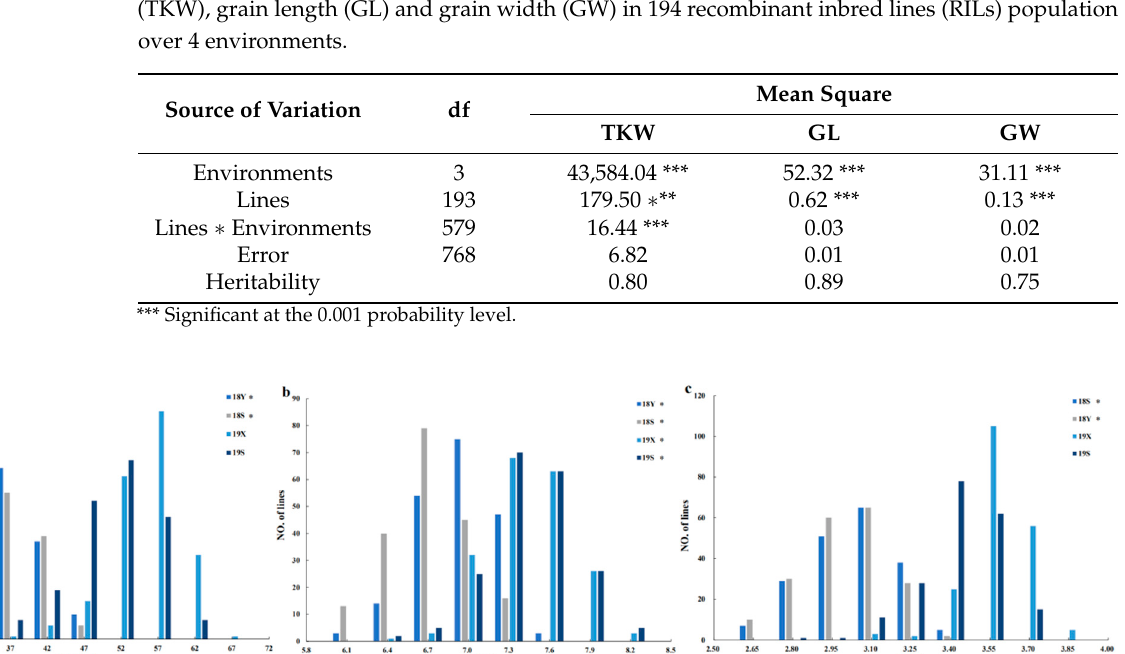
Table 2. Analysis of variance (ANOVA) and broad sense heritability for thousand kernel weight